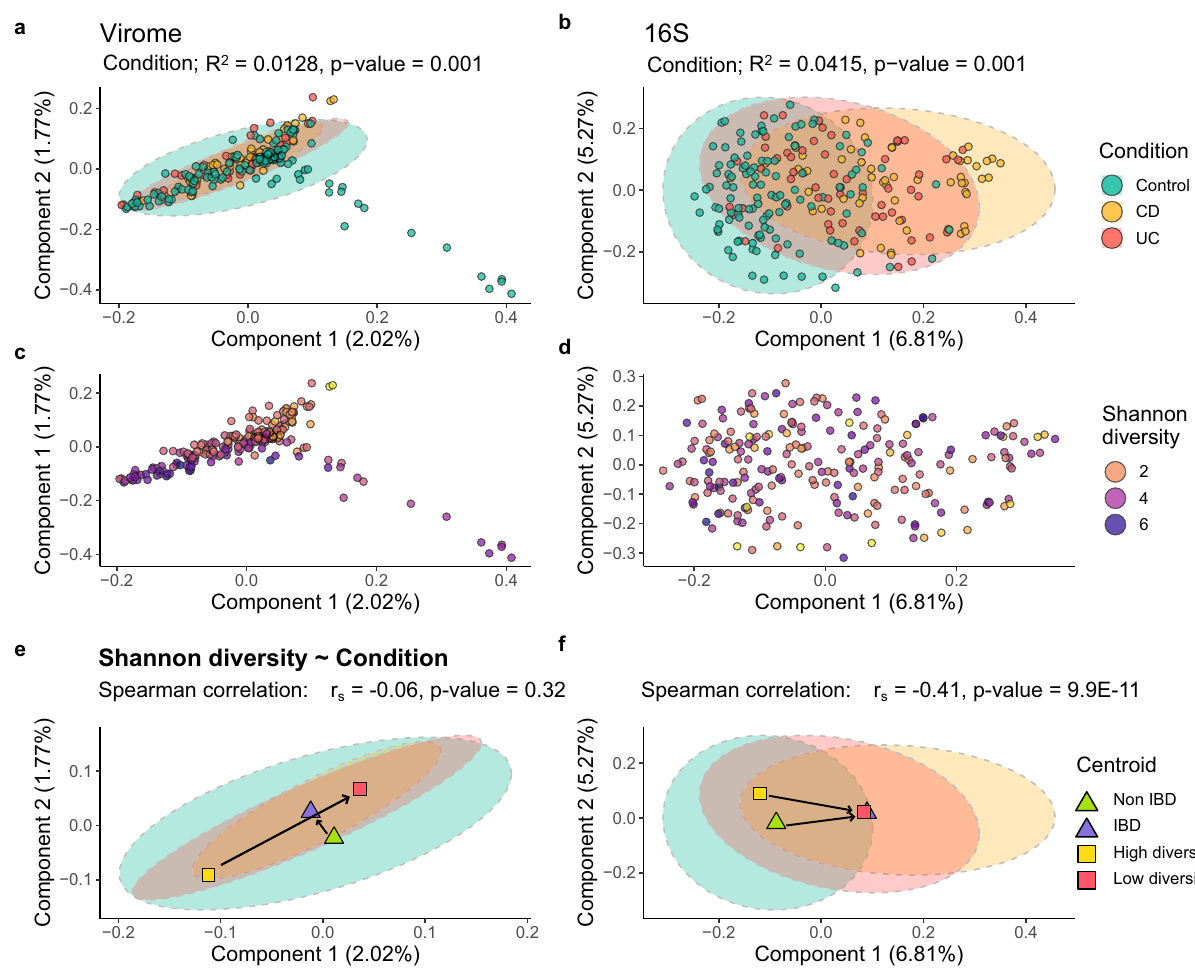
Fig. 2 Diversity analyses of unampli fi ed faecal viromes. PCoA β -diversity ordinations, using Canberra distances, highlighting compositional variation within a unampli fi ed viromes and b 16S rRNA gene compositions, grouped by condition. Again, β -diversity ordinations of c unampli fi ed virome and d 16S data, but each individual sample is coloured by its Shannon index α -diversity value. PCoA centroids for control and IBD sample ordinations, and the top 10 most and least α -diverse samples, for the e unampli fi ed virome and f 16S ordinations. Spearman ’ s correlation (r s ) and p -values are shown above ( e , f ), calculating the association of sample α -diversity to condition. Spearman ’ s correlation coef fi cients ( + / − ): 0.0 – 0.19 = very weak; 0.40 – 0.59 = moderate. Statistics are based on n = 118 control samples, n = 56 CD samples and n = 59 UC